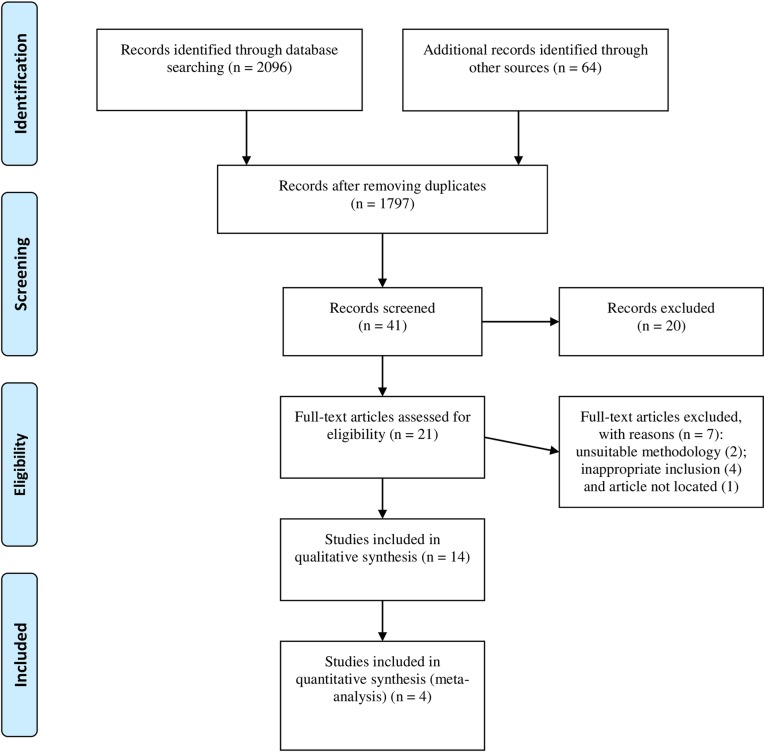
Study flow diagram.